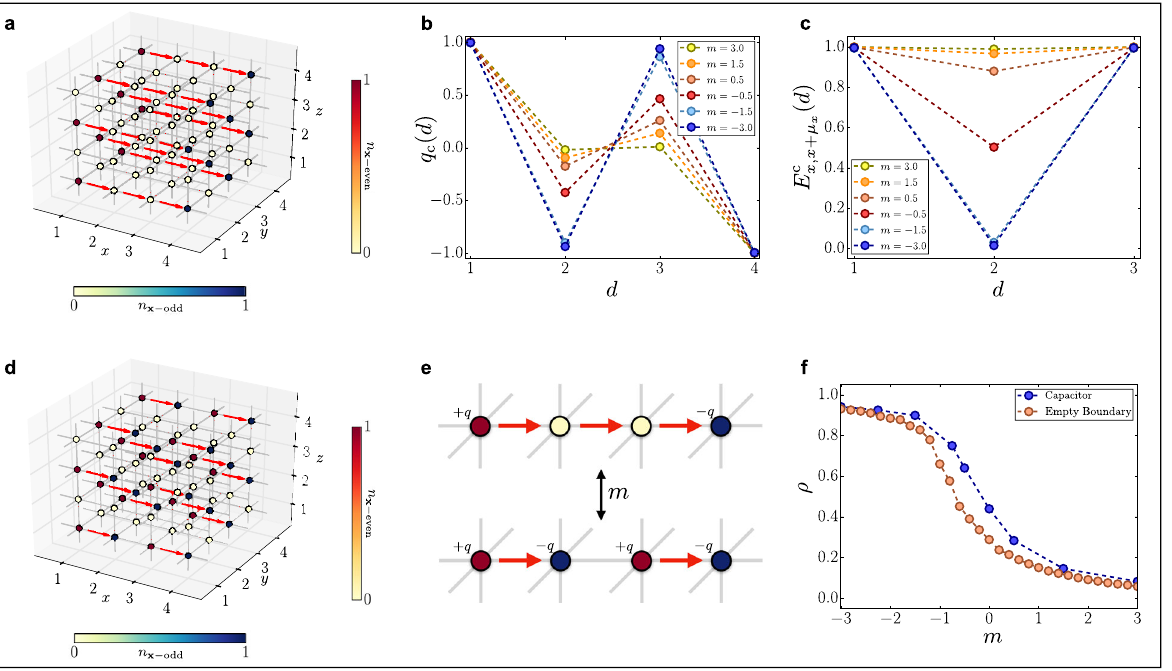
Fig. 3 Quantum capacitor properties. a Ground state con fi guration of the quantum capacitor for m = 3.0. b Mean charge density on the sites along the transverse direction for different values of m . c Mean value of the electric fi eld on the transverse links for different values of m . d Ground state con fi guration of the quantum capacitor for m = − 3.0. e Illustration of the creation of a particle-antiparticle pair along the transverse direction, starting from the initial electric fi eld string generated by the boundary charges. f Particle density as a function of m , with a comparison to the case with no boundary